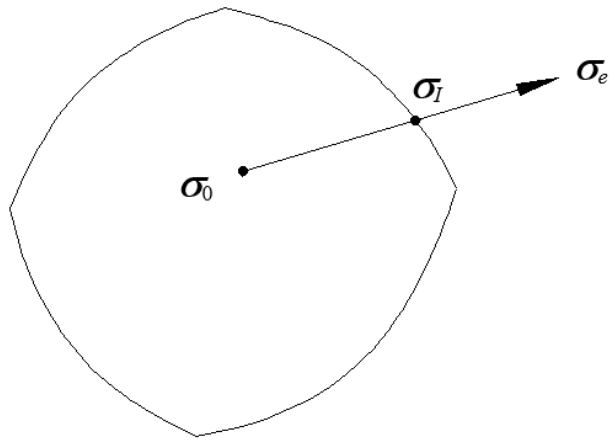
Figure 2. The intersection of the elastic path and the yielding surface.